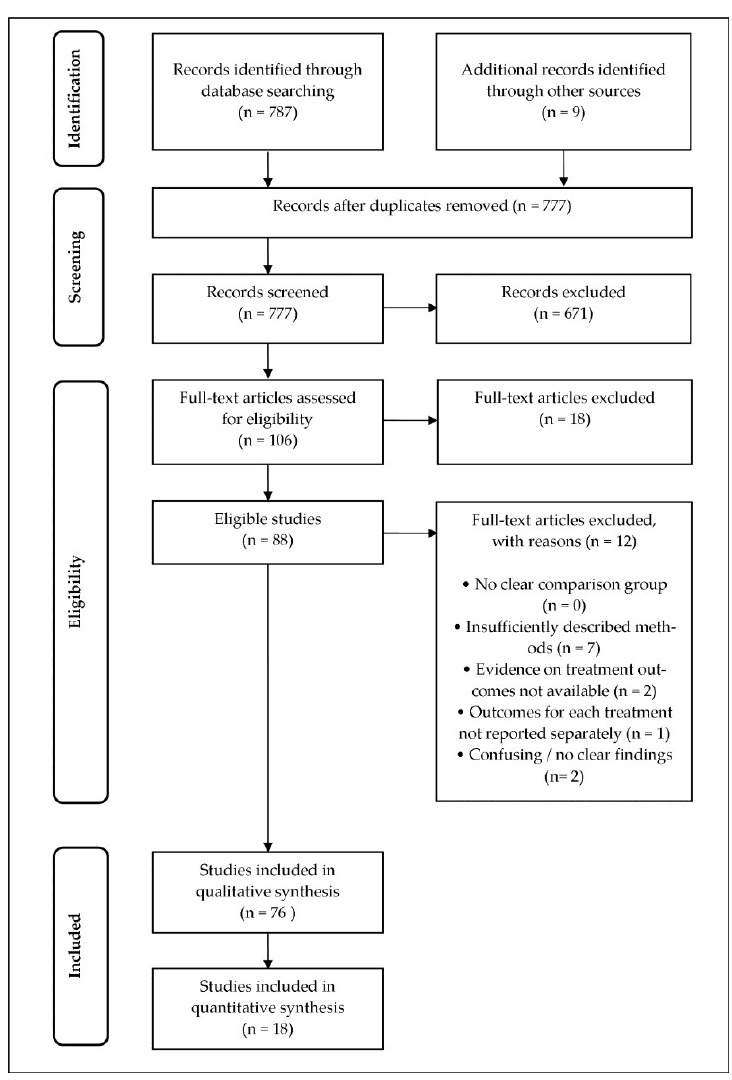
Figure 4. The flow chart of the systematic review information of screening and choosing articles.